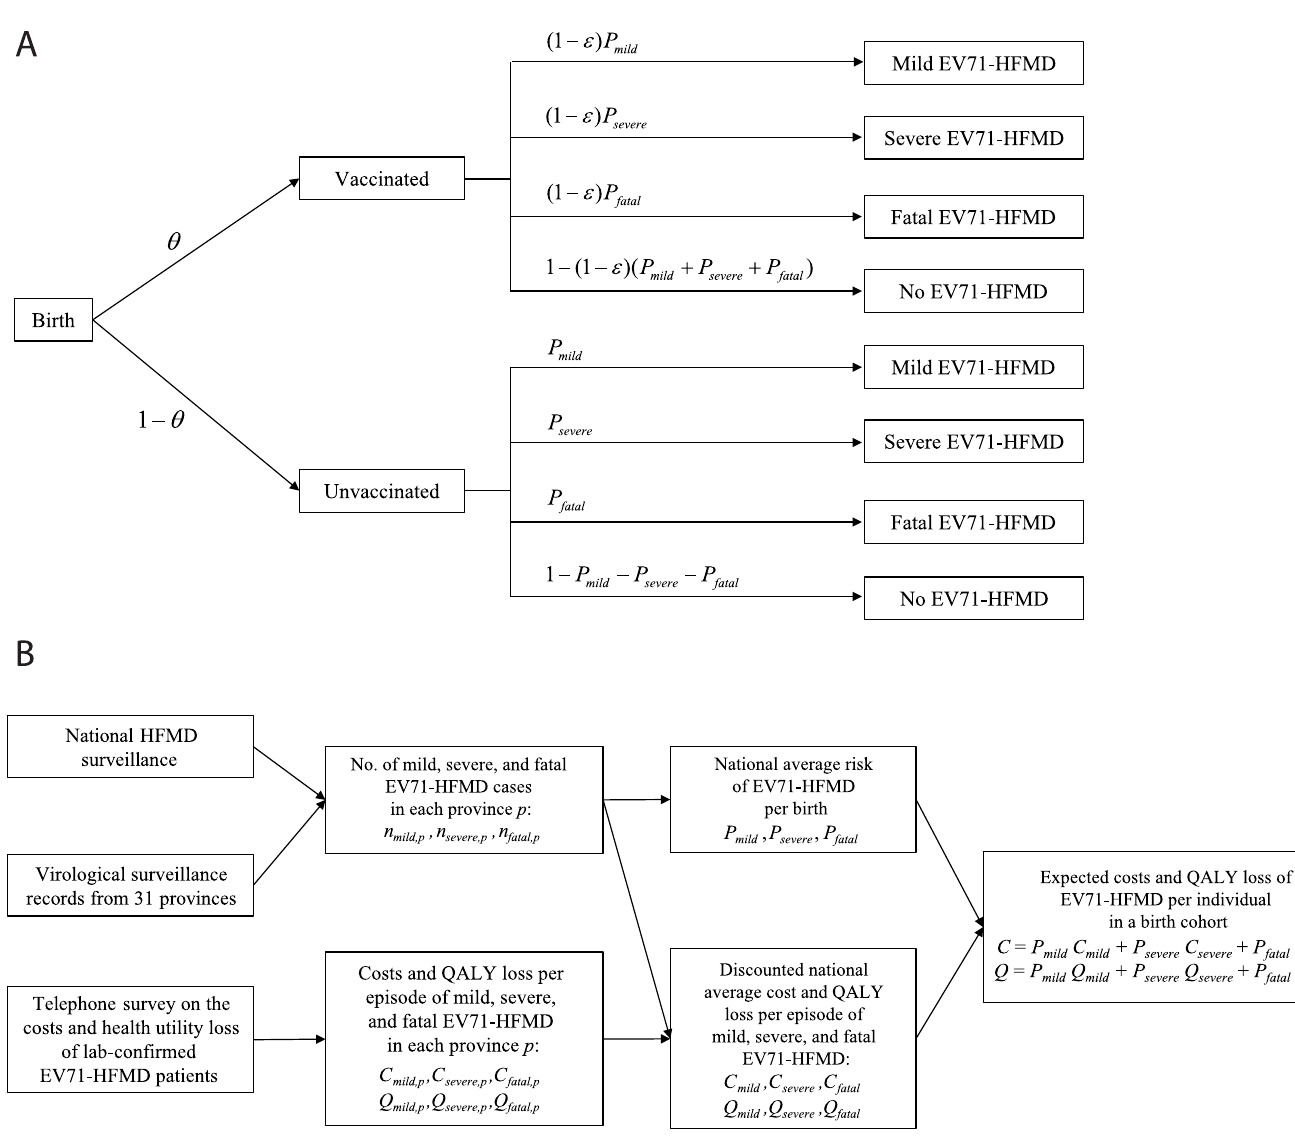
Fig 1. Model structure and parameterization. (A) The static model used in the CEA with vaccine coverage θ and vaccine efficacy ε . (B) A schematic that describes how the data sources were used to parameterize the model. See S1 Text for more details. QALY, quality-adjusted life year.